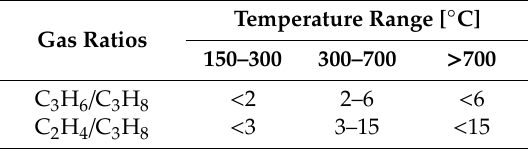
Table 3. Additional criteria for determining the temperature of thermal defect